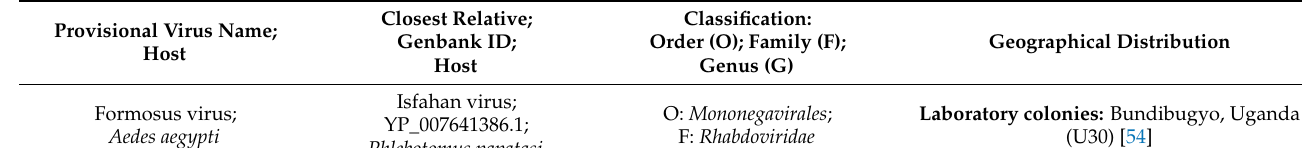
Table 1. Novel and updated viruses of Aedes